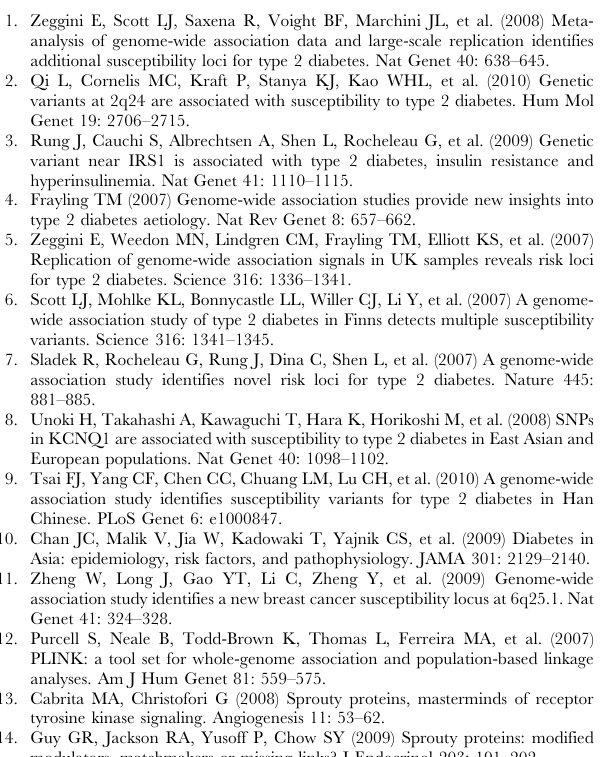
Figure S1 Study design. Figure S2 MDS analyses to confirm all subjects were Asians. Found at: doi:10.1371/journal.pgen.1001127.s006 (1.55 MB TIF)